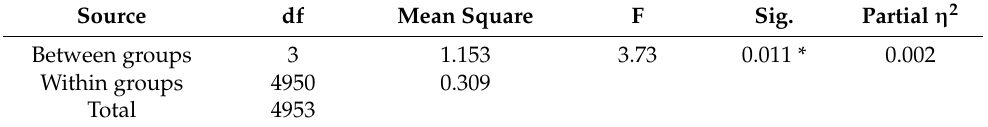
Table 6. Results of ANOVA—perceived social support in mixed media.